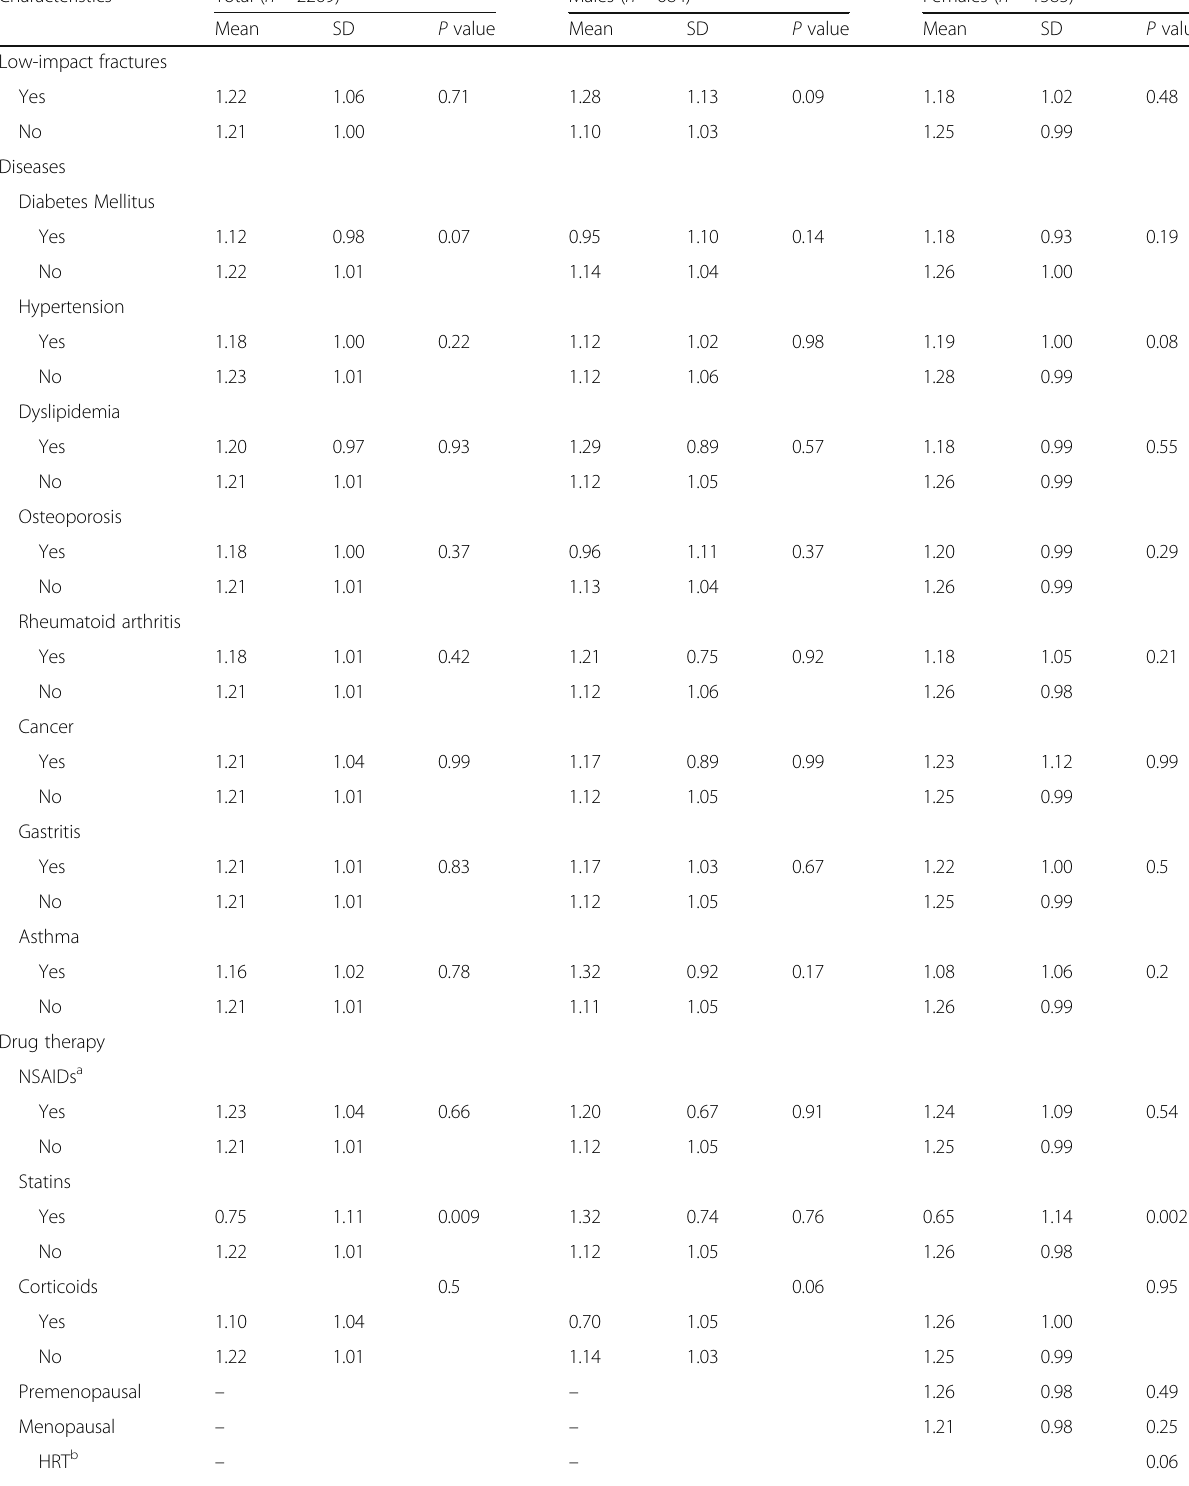
Table 6 Dietary Inflammatory Index, according to gender and concomitant diseases